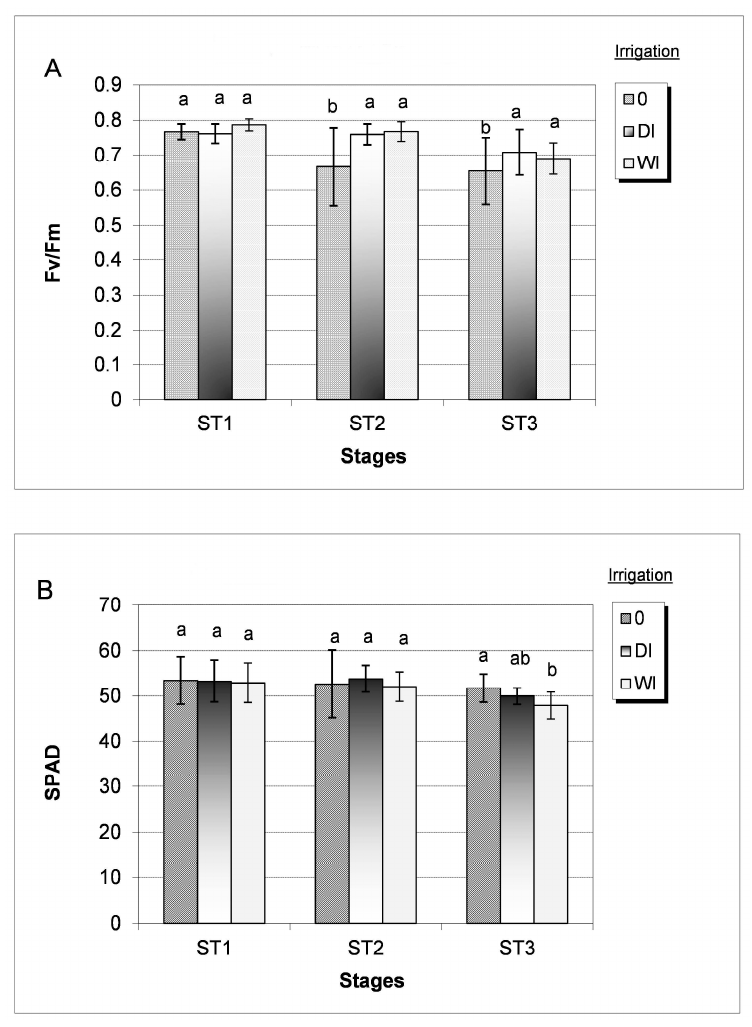
Figure 3. Effect of water supply conditions on chlorophyll fluorescence (Fv/Fm) ( A ) and SPAD ( B ) during the growth stages (ST1 at beginning of flowering, ST2 during flowering with fruit development, ST3 during early fruit development) under non-irrigation (I 0 ), deficit irrigation (DI), and regular irrigation (WI). Data presents the average of years 2015 and 2016 ± SD. Means followed by different letters are significantly different at p < 0.05 using Duncan’s multiple range test.